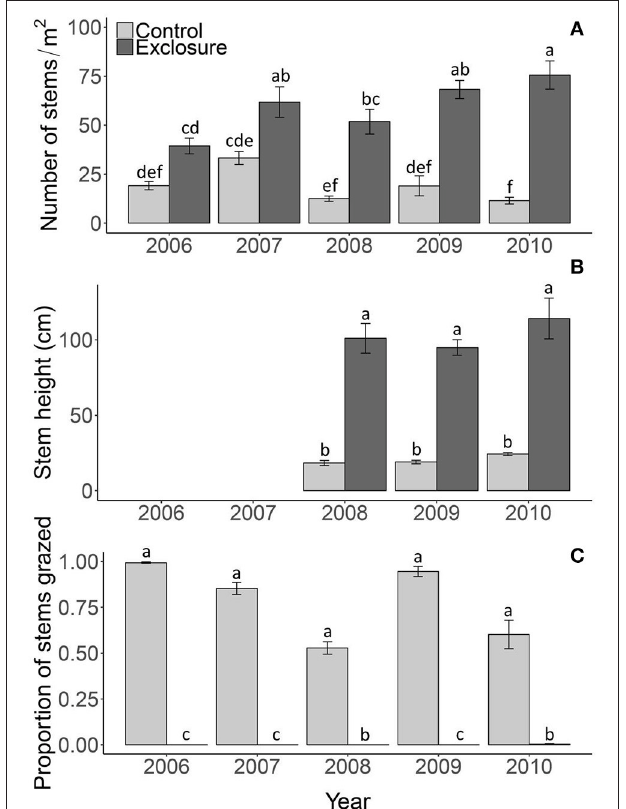
FIGURE 2 | Reed density (A) , stem height above the water (B) and proportion of stems grazed (C) in the control plots and exclosures. Data are means ± SE, n = 6. Different letters indicate significant differences among the control and exclosure treatments and years at P <